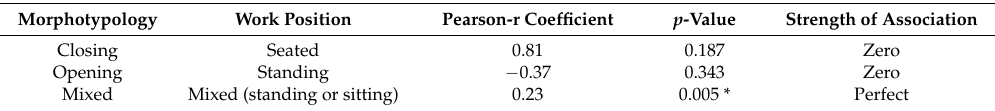
Table 1. Correlation between morphotypology and work position.